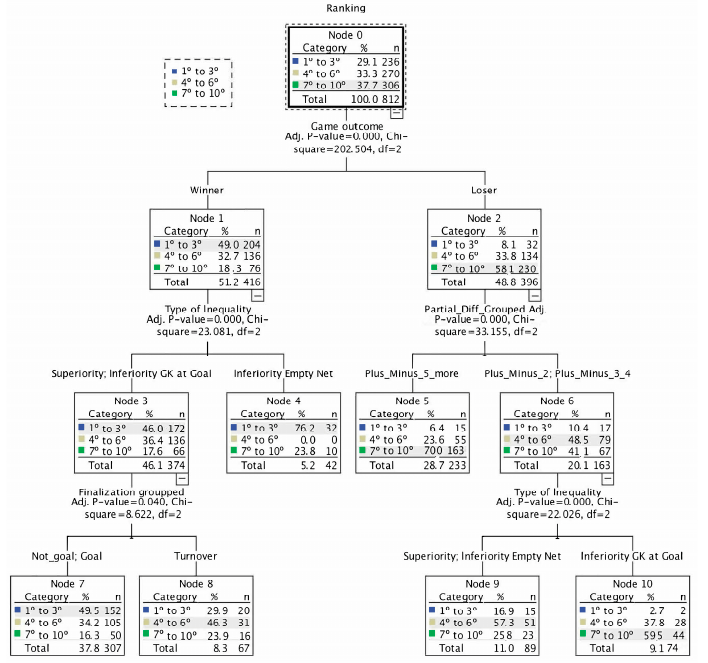
Figure 1. Decision tree using the exhaustive CHAID algorithm to predict the offensive performance during exclusions according to the final ranking.